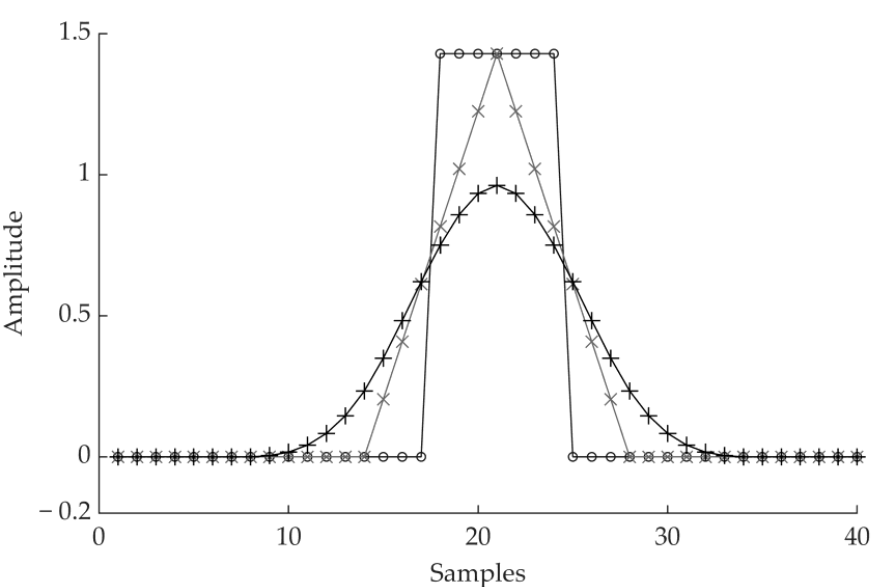
Figure 1. Impulsive response of a moving average cascade. The straight line with the ◦ marker is a single moving average. The triangular shape with the × markers results from two moving averages of the same length in cascade. The curve with the + markers results from a cascade of four moving averages.